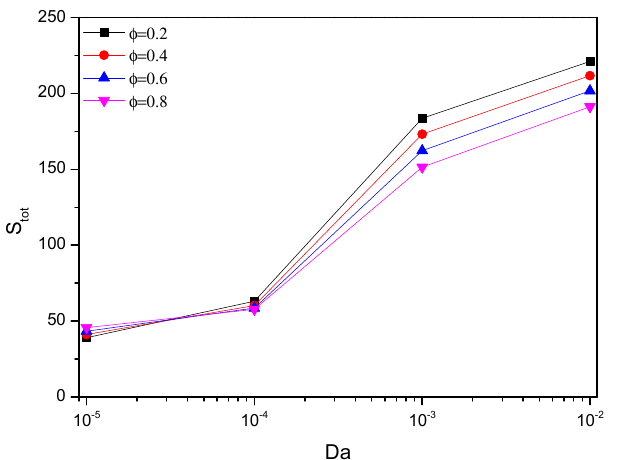
Figure 25. Total entropy as a function of Darcy number (Da) at various values of φ . Ra = 10 6 , ε = 0.4 and Ha = 0.